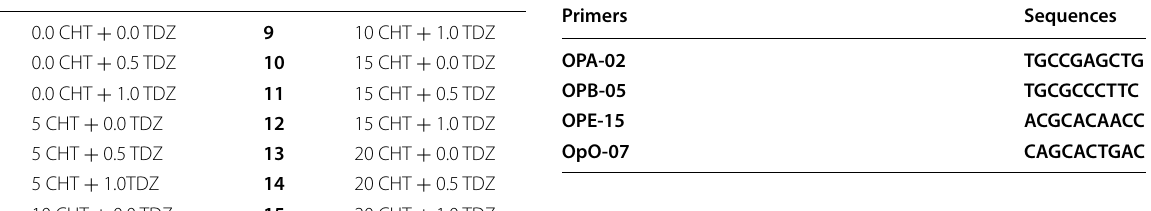
Table 1 Treatments that applied in this study No.